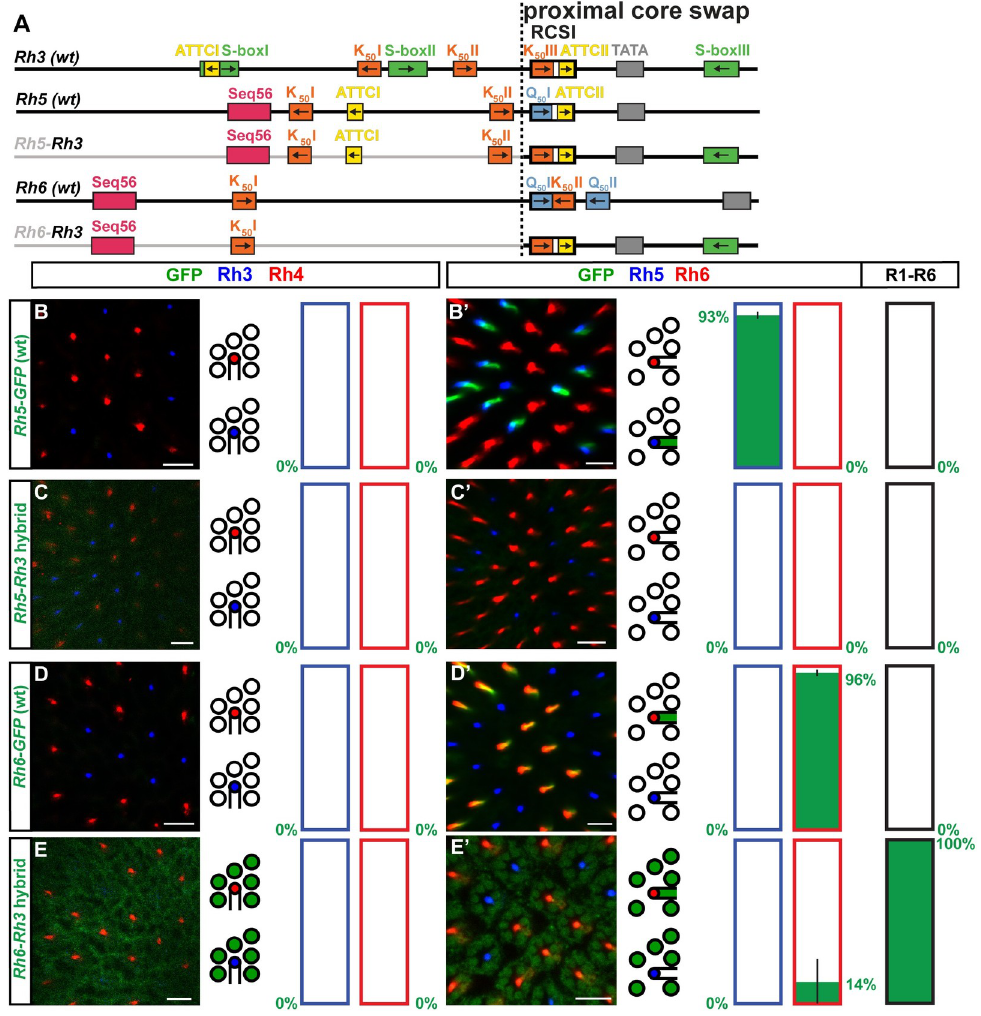
Fig 9. Shared cis -regulatory features do not predict the compatibility of distal and proximal promoter regions. (A) Schematic comparison of wild type promoters and hybrids to test the reverse compatibility of hybrids that had compatible motif combinations (see text). Note shared motifs such as K 50 motifs and ATTC motifs. The dotted vertical lines indicate the break/fusion point of the hybrids immediately upstream of the RCSI motif that is found in a similar position in all Rhs . (B)—(E) Wild type promoters and hybrids driving GFP reporter expression (green) in the R7 layer. Rh3 (blue) labels pR7s and Rh4 (red) labels yR7s. Bar graphs show GFP co-expression in the Rh3 or Rh4 subset, respectively. (B’)—(E’) Wild type promoters and hybrids driving GFP reporter expression (green) in the R8 layer. Rh5 (blue) labels pR8s and Rh6 (red) labels yR8s. Bar graphs show GFP co-expression (green) in the Rh5, Rh6, or R1-R6 subset. Green numbers indicate the mean percentage of co-expressing photoreceptors, error bar represents standard error of the mean. (B) and (B’) The wild type Rh5 promoter drives subtype-specific GFP reporter expression in the pR8/Rh5 subset (statistics are the same as in Fig 5D–5D’). (C) and (C’) The Rh5 - Rh3 hybrid does not drive detectable GFP expression in photoreceptors. N = 12 retinas and n = 732 R7s for (C); N = 9 retinas, n = 576 R8s and 3,456 R1-R6 PRs for (C’). (D) and (D’) The wild type Rh6 promoter drives subtype-specific GFP expression in the yR8/Rh6 subset. N = 12 retinas and n = 786 R7s for (D); N = 12 retinas, n = 1,313 R8s and 7,878 R1-R6 PRs for (D’). (E) and (E’) The Rh6 - Rh3 hybrid drives weak GFP expression in R1-R6 and some yR8s. N = 7 retinas and n = 565 R7s for (E); N = 10 retinas, n = 690 R8s and 4,140 R1-R6 PRs for (E’). Scale bars, 10 μ m.